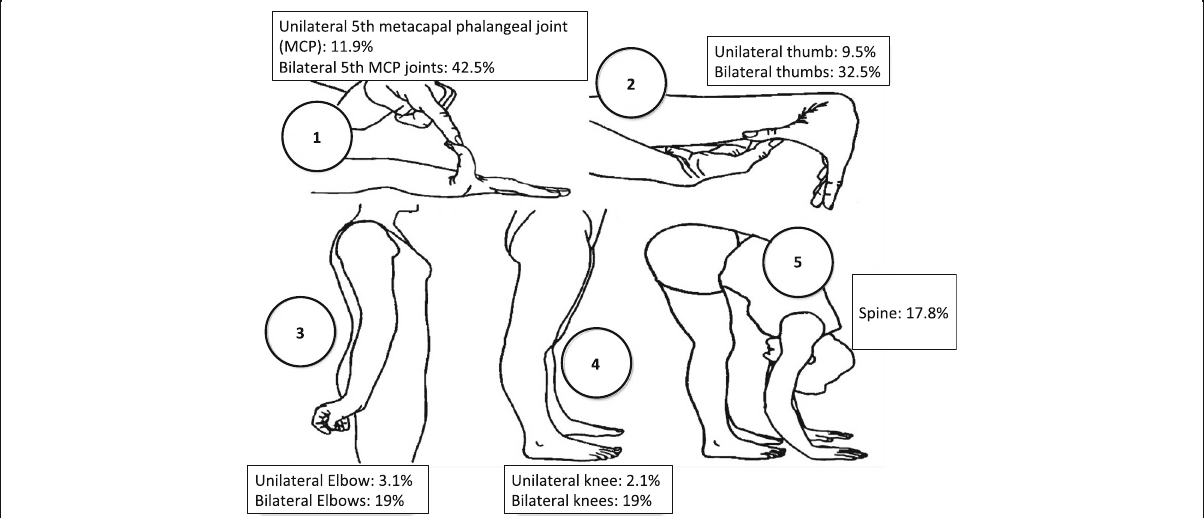
Fig. 1 Percentage frequencies of unilateral or bilateral signs of hypermobility identified through 5 maneuvers in the Beighton scale: 1) extension of the 5th metacarpal phalangeal joint by placing the 5th finger parallel to the forearm, 2) extension of the thumb touching the flexor side of the forearm, 3) extension greater than 10 o beyond the limit of 180 o of the elbow, 4) extension greater than 10 o beyond the limit of 180 o in the knee, and 5) flexion and elongation of the spine by placing the hands flat on the floor with knees in maximum